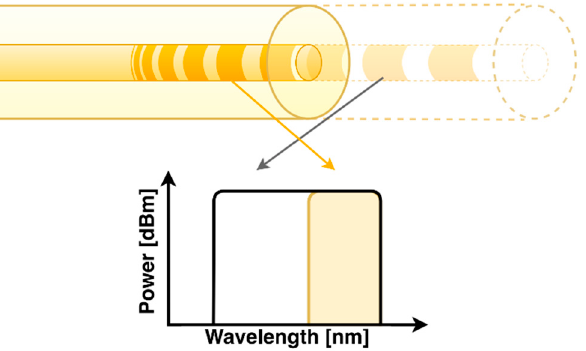
Figure 1. Scheme, showing the relation between the spatial position of the grating and reflected signal.